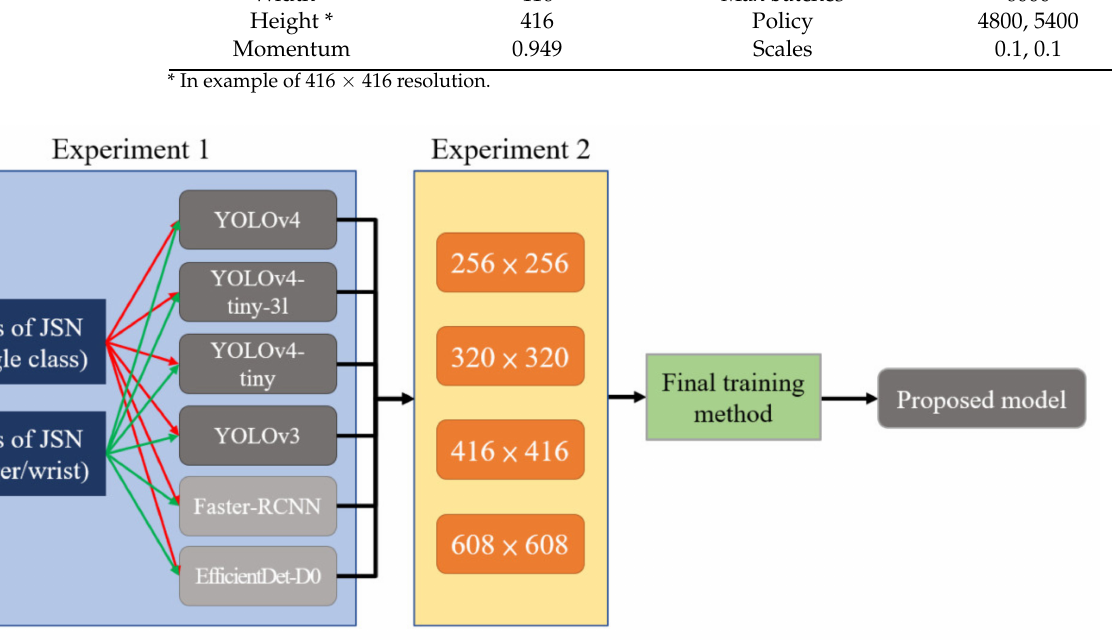
Figure 5. training strategy of detection models in this